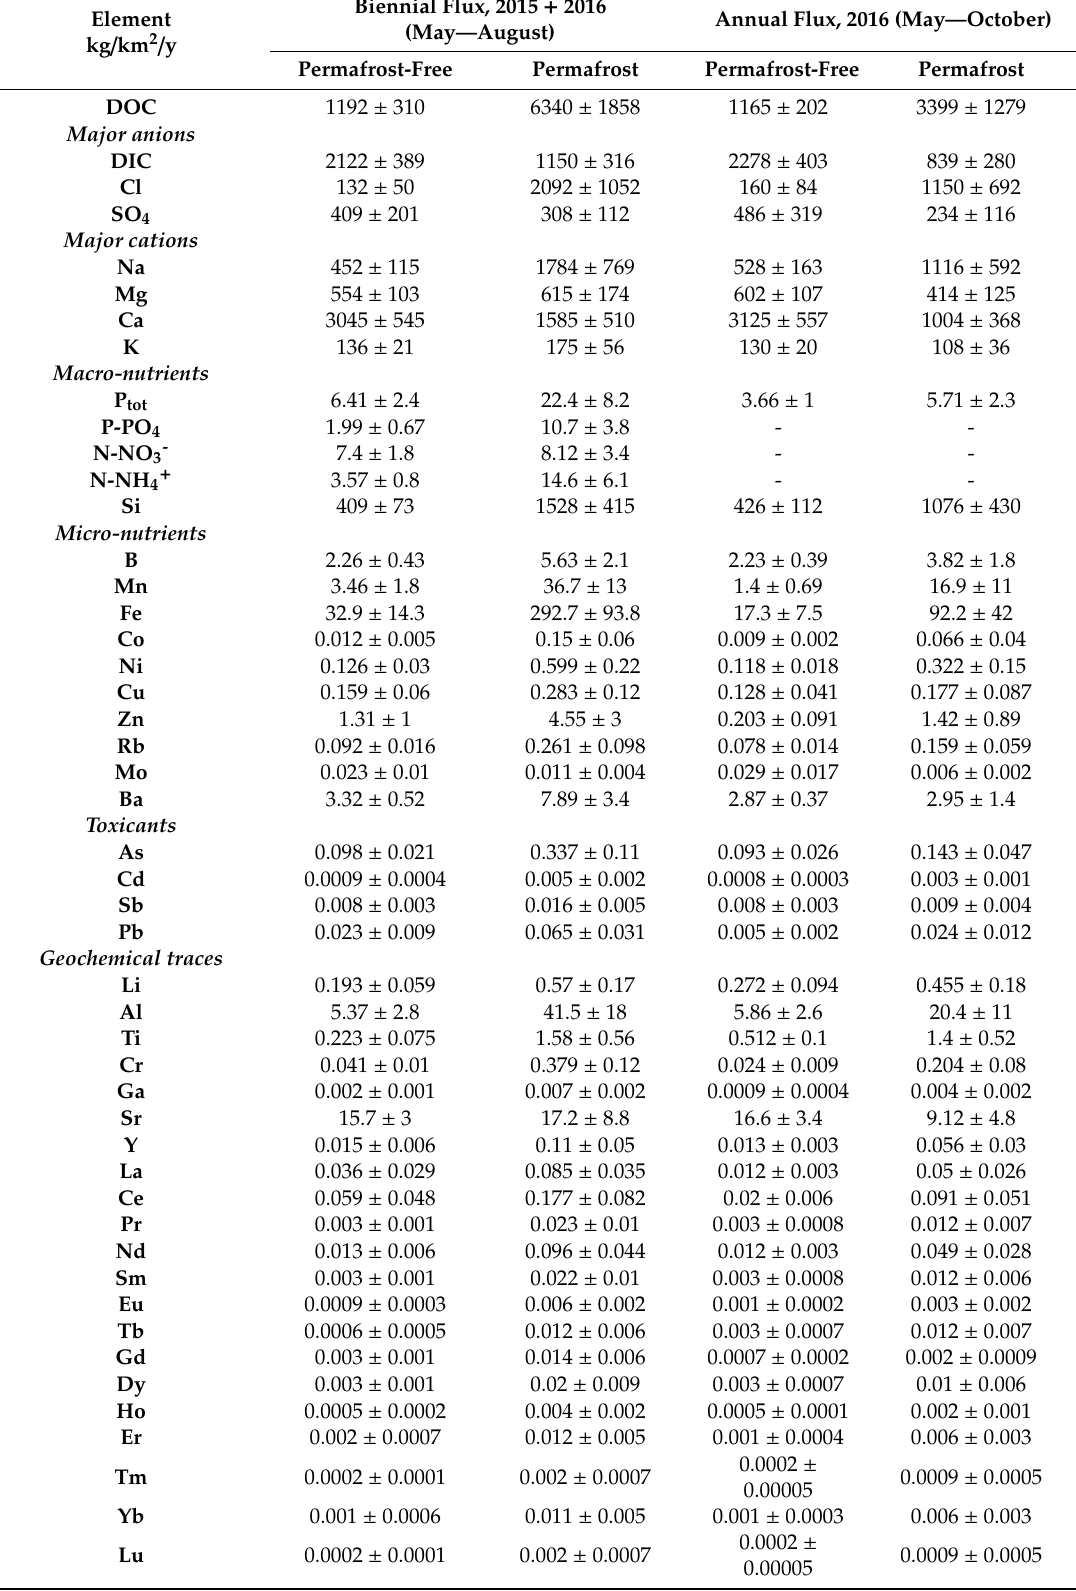
Table 1. Mean ( ± SD) export fluxes of major and trace elements by WSL rivers in the permafrost-free and the permafrost